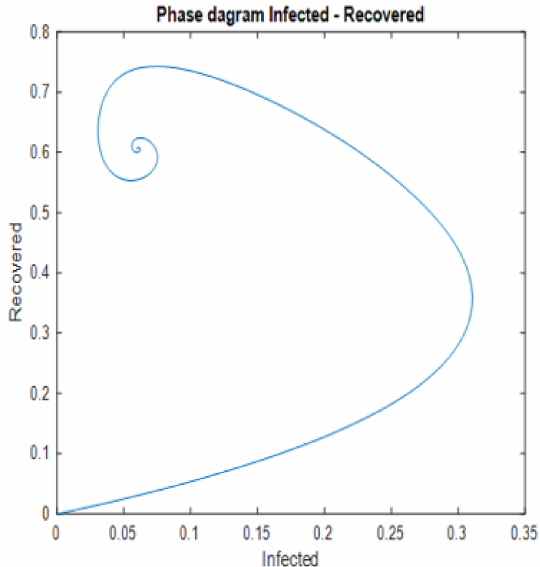
Figure 9. Phase portrait of R against I, for the stable state of the CSIR model.